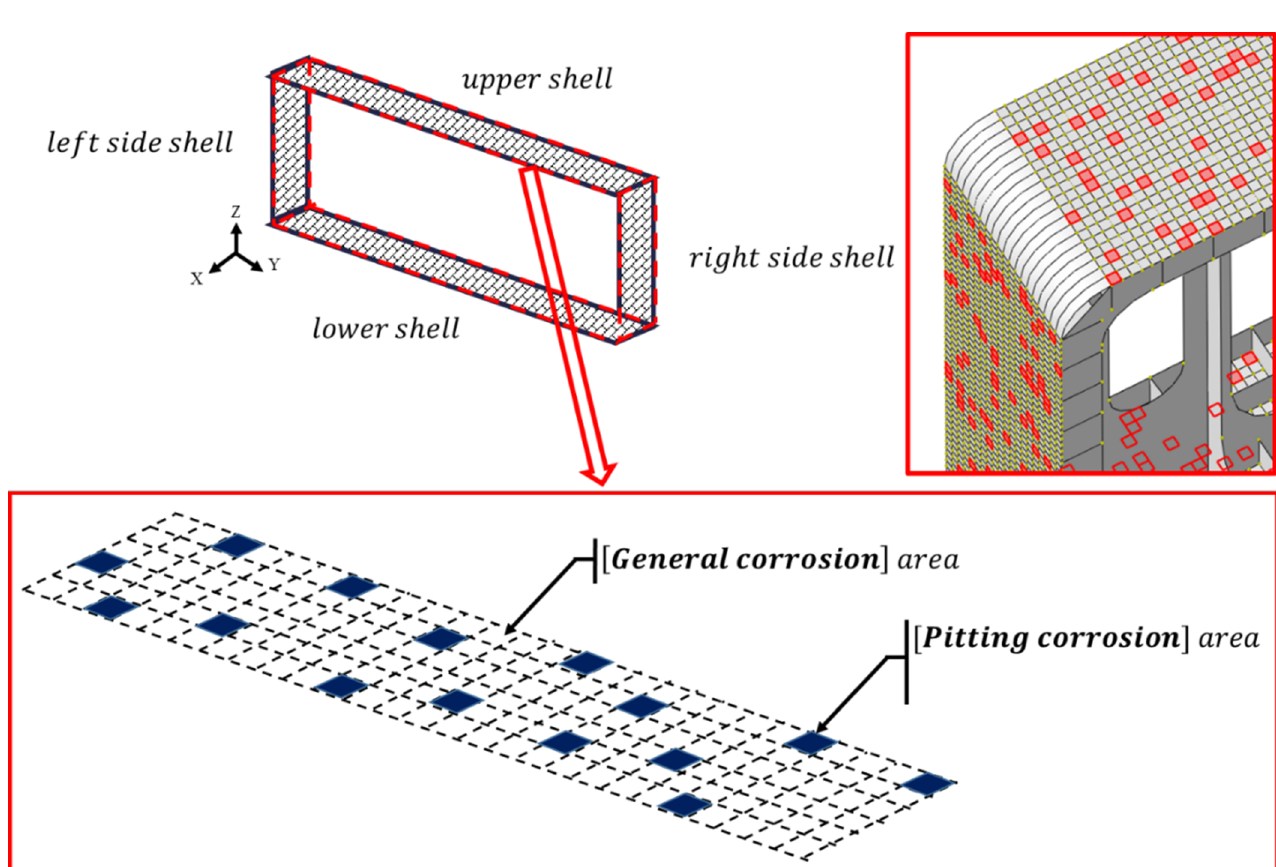
Figure 5. Configuration of pitting corrosion in outer shell.